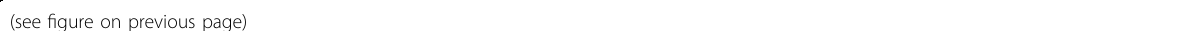
Fig. 4 Adiabatic mode converters with the advanced matching of arbitrary modes. All images (LED, laser) in a and b have the same frame size of 30 × 30 µm. Scale bars are 10 µm. a Left: circular – Rectangular mode converter that couples single-mode fi bers (circular shape mode) to rectangular shape waveguides (elliptical shape mode). A waveguide with length of 1.32 cm was measured to have ultra-low total loss of 0.59 dB (coupling + propagation). The coupling loss was calculated to be 0.19 dB (95.7% light coupled). Middle: LED-illuminated microscopic images demonstrating classic multiscan technique is not capable to fabricate these high-quality mode converters while SPIM-WGs technique enables this capability. About 1550-nm laser-mode pro fi les are presented for SPIM-WGs. Right: plots of intensity versus distance for corresponding SPIM-WGs circular and elliptical mode pro fi les. Plotting lines are indicated in mode pro fi les. b Circular-ppKTP mode converter that couples single-mode fi bers to ppKTP waveguides. A waveguide with length of 1.38 cm was measured at 1550 nm wavelength to have total loss of 0.65 dB (coupling + propagation). The coupling loss was 0.24 dB (94.6% light coupled). c Circular – rectangular TE01 mode converter that converts between Gaussian circular mode with rectangular TE01 mode (also called LP11 mode in waveguide theory). A waveguide with length of 1.27 cm was measured at 785 nm wavelength to have ultra-low total loss of 0.78 dB (coupling + propagation). The coupling loss was calculated to be as low as 0.2 dB (95.5% light coupled). d Circular – circular TE01 mode converter that converts between Gaussian circular mode with circular TE01 mode or a hollow ring shape intensity distribution. A waveguide with length of 1.27 cm was measured at 785 nm wavelength to have total loss of 0.73 dB (coupling + propagation). The coupling loss was calculated to be 0.21 dB (95.3% light coupled). e Top: COMSOL simulated fi eld distribution of designed circular shape mode pro fi le to match a single-mode fi ber at 1550 nm. Middle: COMSOL simulated fi eld distribution of designed mode pro fi le to match ppKTP waveguide at 1550 nm. Bottom: designed refractive index pro fi le for matching ppKTP waveguide mode. f Top: COMSOL simulated fi eld distribution of designed circular shape mode pro fi le to match a single-mode fi ber at 785 nm. Middle: COMSOL simulated fi eld distribution of designed rectangular TE01 mode pro fi le at 785 nm. Bottom: COMSOL simulated fi eld distribution of designed circular TE01 mode pro fi le at 785